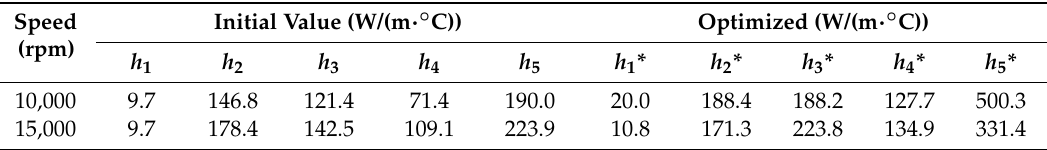
Table 4. The heat transfer coefficients.